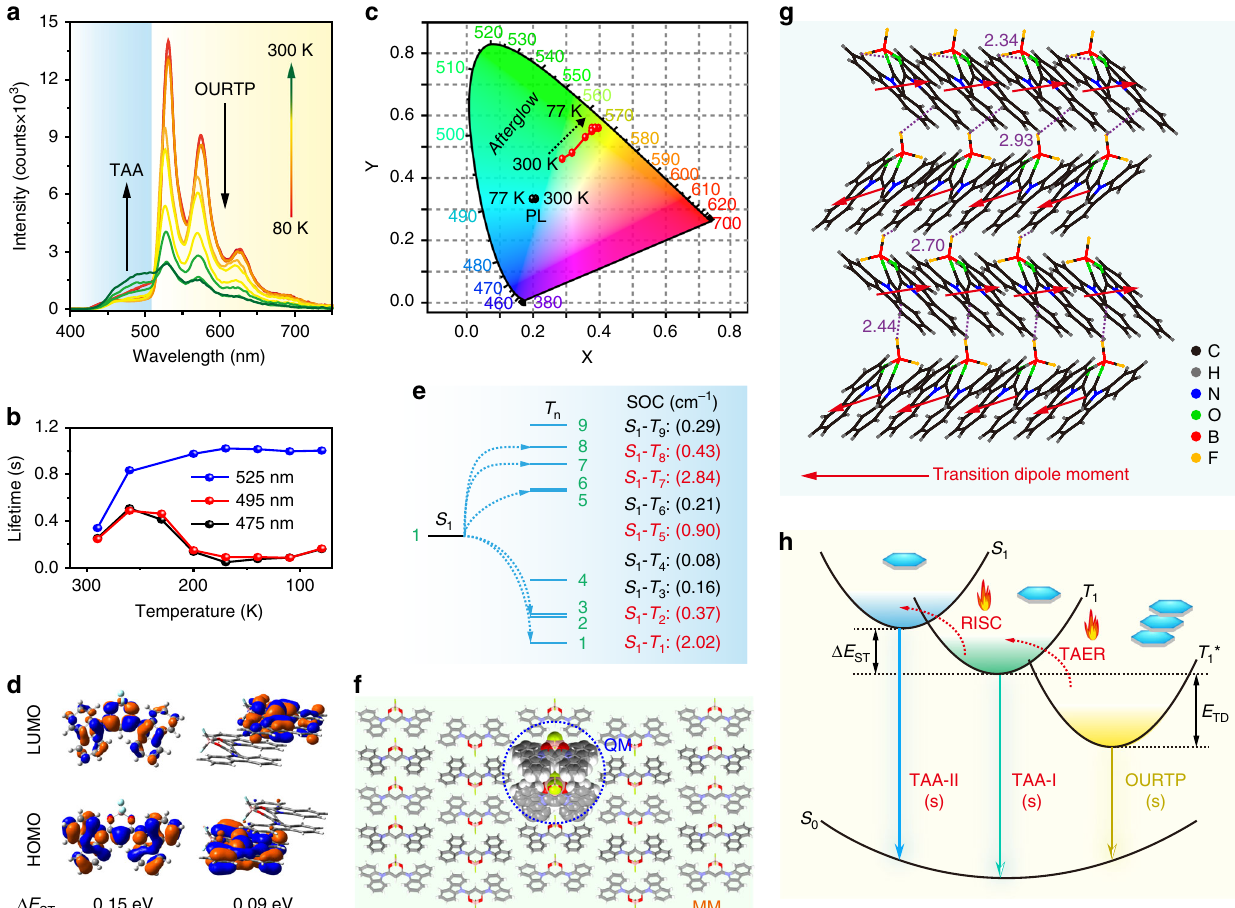
Fig. 3 Proposed mechanism for the thermally activated organic afterglow. a Temperature-dependent afterglow spectra from 80 to 300 K of DCzB crystal. b Lifetimes of 475, 495, and 525 nm afterglow at different temperatures. c CIE 1931 coordinates of steady-state PL and afterglow emission from 80 to 300 K. d HOMO and LUMO isosurfaces of DCzB in single molecular and dimer states. e TD-DFT calculated energy level diagram and the corresponding SOC constants. f QM/MM model of DCzB molecule, the hydrogen atoms were ignored for clarity. g Molecular packing and inter/intra-molecular interactions in DCzB crystal. h Proposed mechanism of the highly ef fi cient tri-mode afterglow. The excitation wavelength is at 380 nm. Source data are provided as a “ Source Data fi le ”